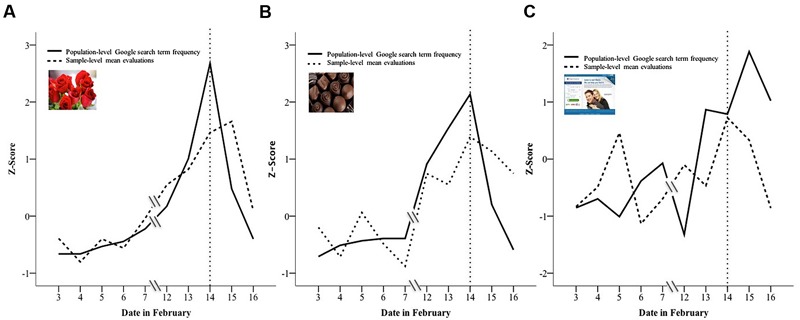
Sample-level mean evaluations (dotted line) and population-level Google search term frequency (solid line) as a function of date in February for roses (A), chocolates (B), and an online dating category (C). Sample-level mean evaluations and Google search term frequency are reported in standardized units to facilitate comparison. The dotted vertical line on 14th of February on the x-axis indicates Valentine’s Day. To provide a better estimate of the relationship between search terms and evaluation of objects, we used evaluation data from all available days (2/3/15 to 2/16/15). Google search term frequency is a relative measure based on the total number of Google searches for the particular term specified in the U.S. during the time period being examined. The maximum query frequency in the time period specified is standardized to 100, and the query frequency at the initial date being examined is standardized to be zero by Google Trends. Thus, the absolute values of the search frequency are not interpretable; only the relative changes across time within a Google Trends query are interpretable.